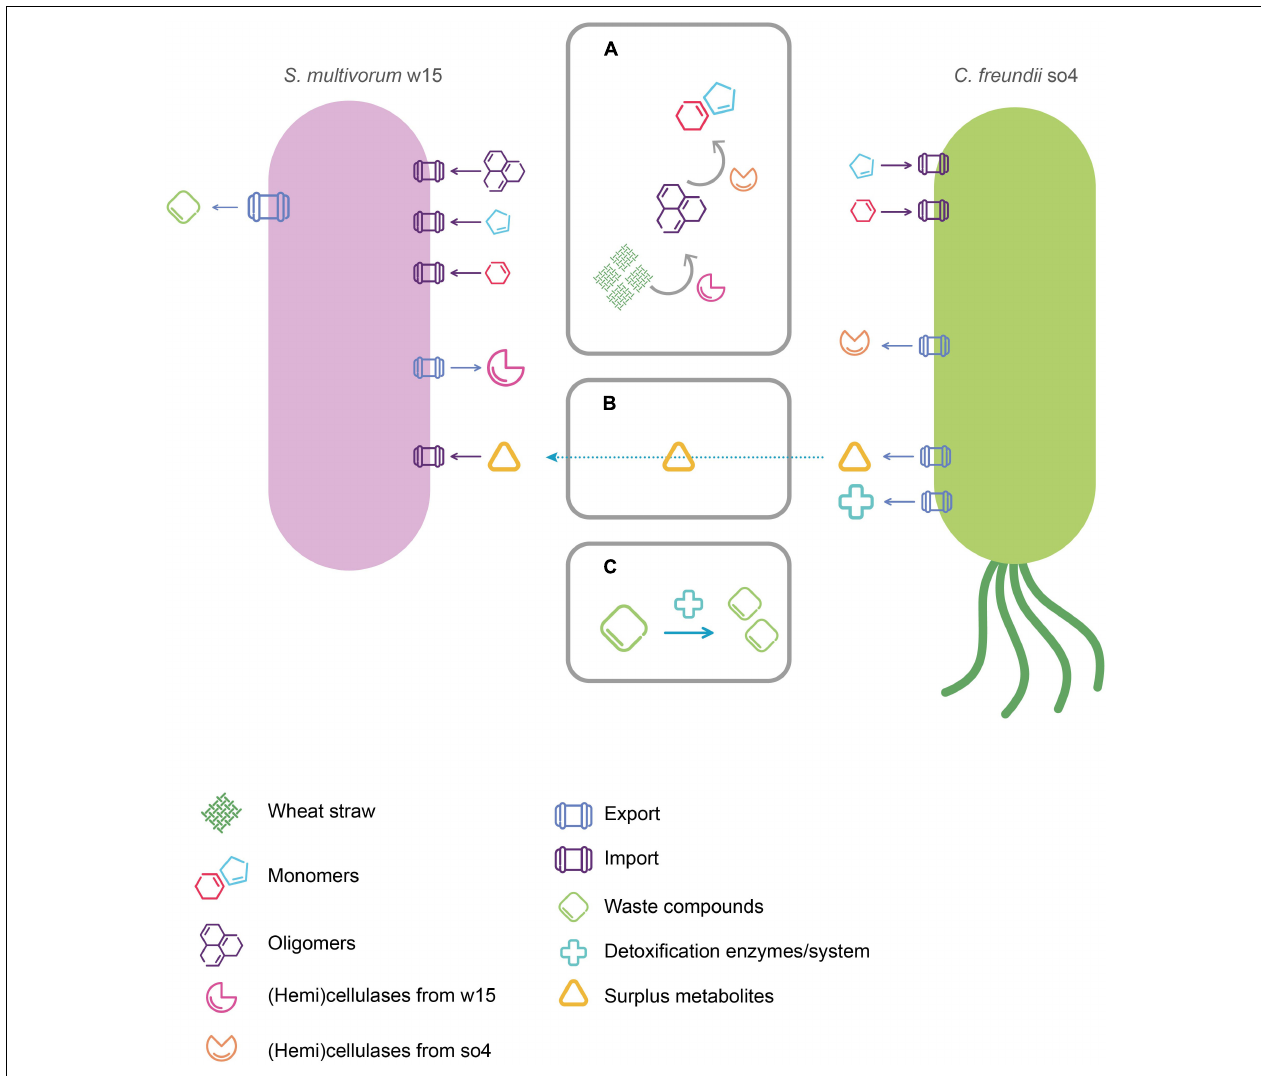
FIGURE 5 | Proposed roles of C. freundii so4 and S. multivorum w15 in the degradation of wheat straw, and mode of interaction. (A) Attack on wheat straw by (hemi)cellulases produced by C. freundii so4 and S. multivorum w15 (attacks on other compounds not depicted). (B) Potential metabolites of C. freundii so4 captured by S. multivorum w15. (C) Waste/toxic compounds removed by C. freundii so4.